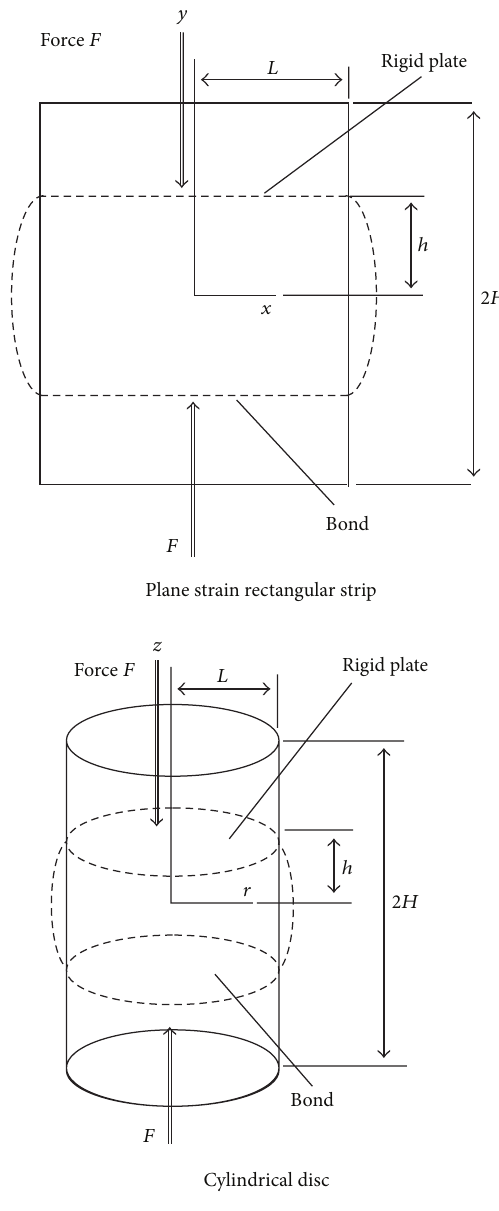
Figure 2: Bonded